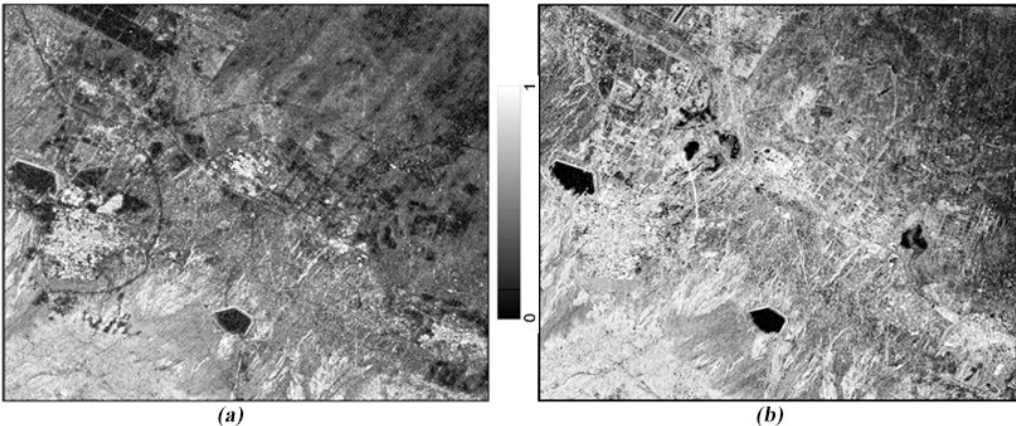
Figure 3. Coherence images of the interferograms generated from the data pair ( a ) (20 January 2007 and 10 December 2008, B p = 643 m) and ( b ) (10 December 2008 and 25 January 2009, B p = 472 m).